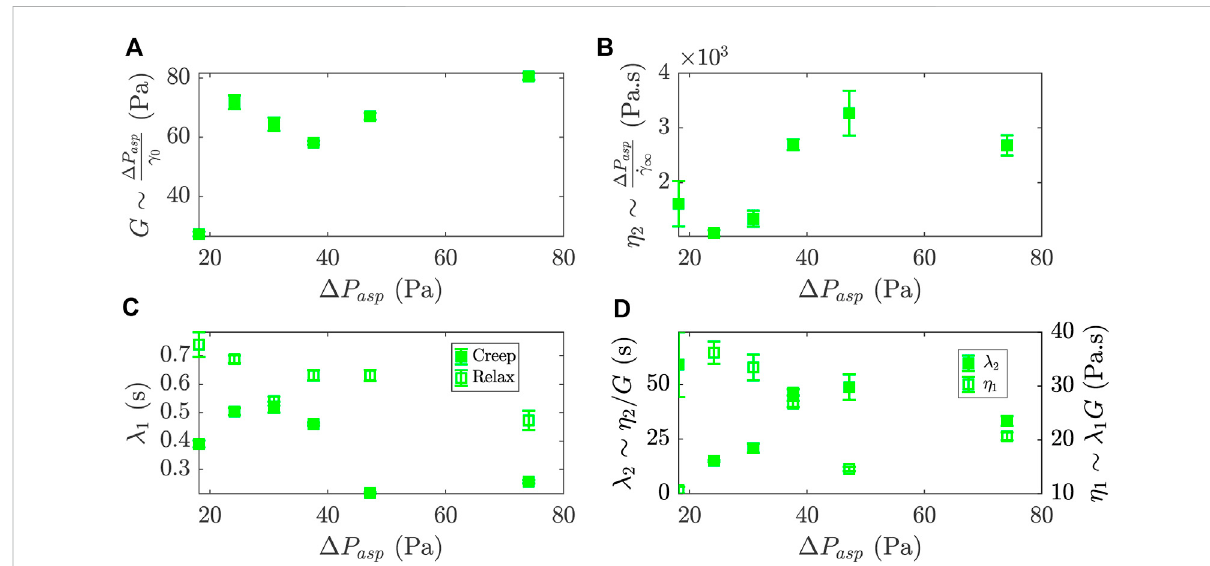
FIGURE 4 Rheologicalparametersof a2%-biotin prototissue deduced from thegeneralized Kelvin-Voigt fl uid model and their evolution with the steps in aspiration pressure, Δ P asp . (A) Effective elastic modulus, G (B) Effective viscosity, η 2 . (C) Retardation times, λ 1 , for the creep and relaxation phases (full and empty symbols respectively). (D) Relaxation time, λ 2 , de fi ned as the ratio η 2 / G and viscosity η 1 de fi ned as λ 1 G . Error bars were obtained by propagating the errors obtained over the fi tting